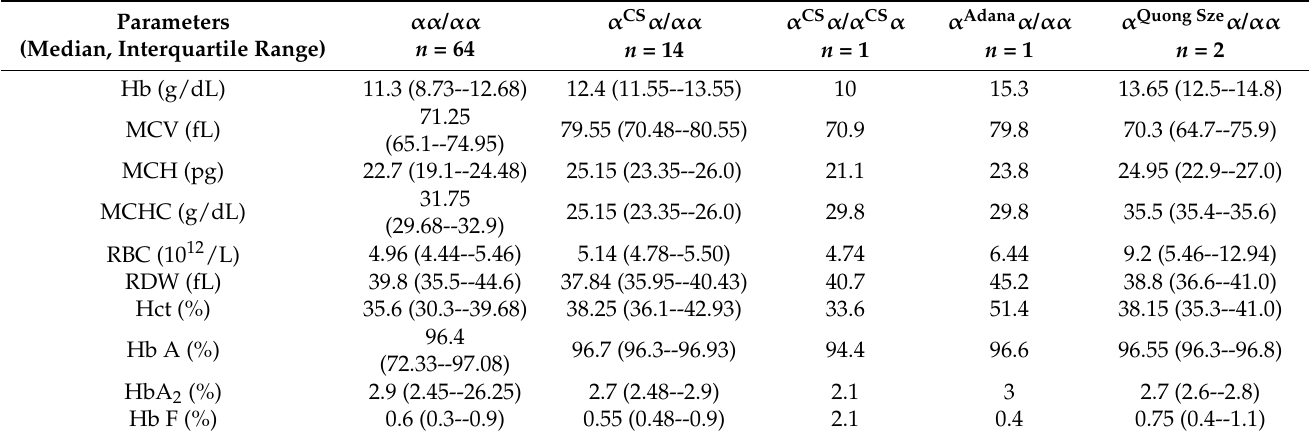
Table 3. Haematological parameters among nondeletional mutations of α -thalassaemia patients. Parameters